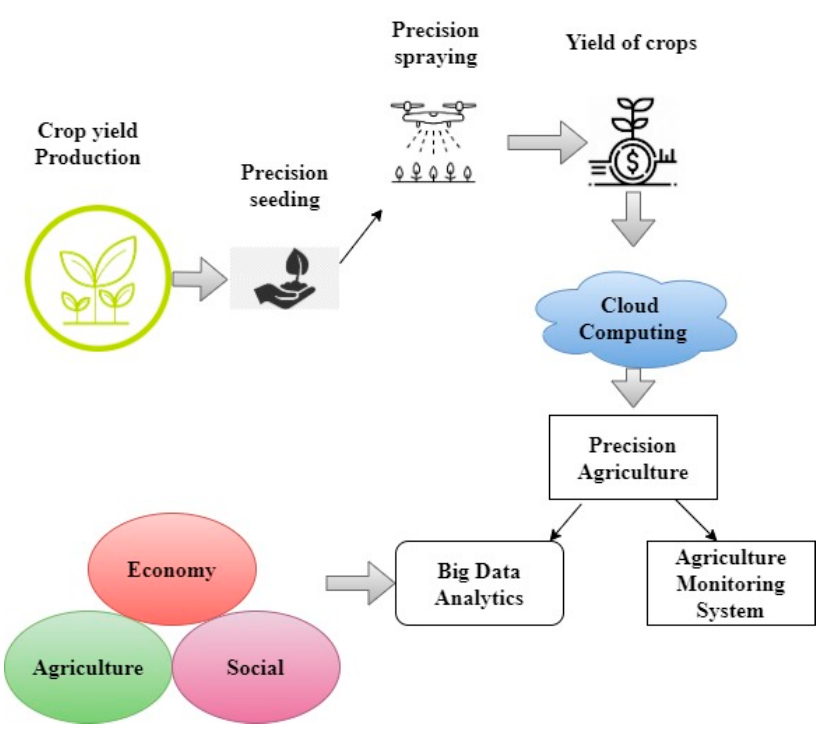
Figure 1. The agricultural monitoring system.